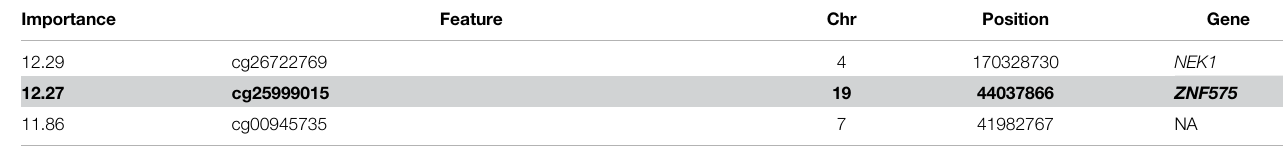
TABLE 3 | ( Continued ) Top 50 predictive features of the best-performing model for predicting overweight/obesity status in the FOS.